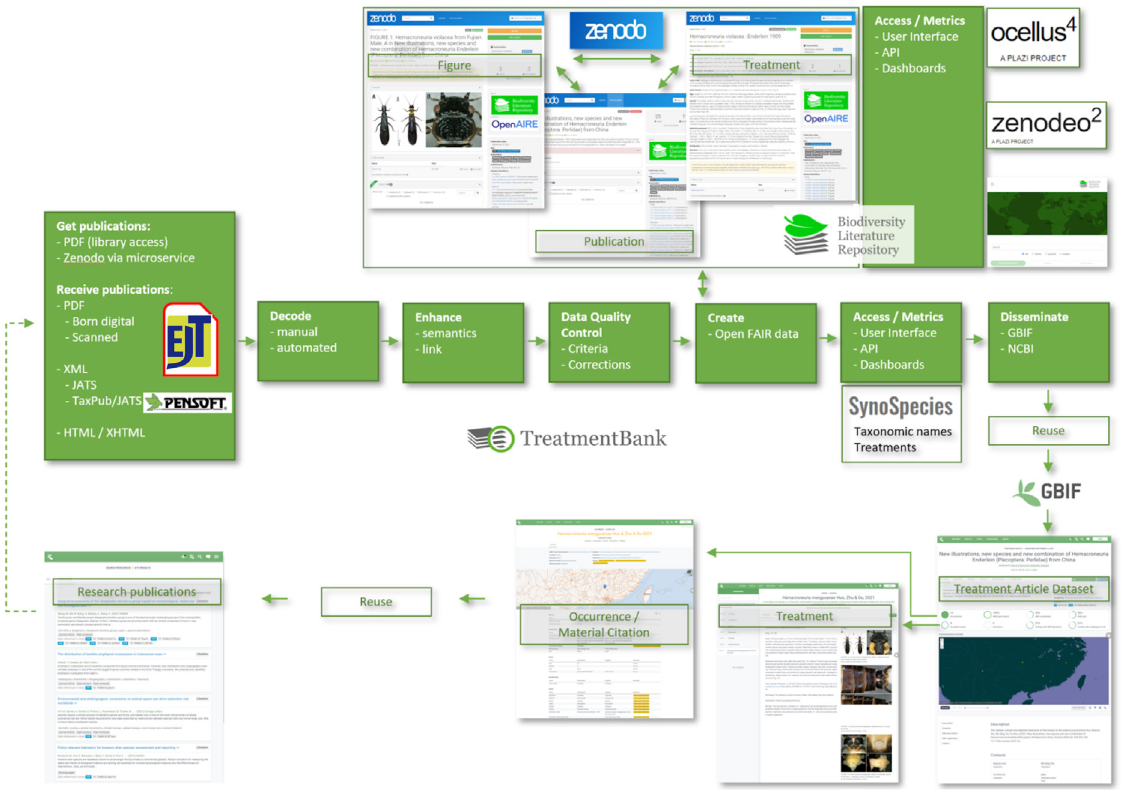
Fig. 1. Publishing as part of the research life cycle. Once liberated, the data imprisoned in a single PDF immediately becomes an integral part of research and is reused and cited. Green figures illustrate the TreatmentBank workflow to liberate, FAIRize and disseminate data, and the Biodiversity Literature Repository, the long-term repository for the data. GBIF is one of the main reusers of the data, providing specific access to the material citations and making them FAIR. Finally, scientists reuse data from within GBIF for their research, for example new revisions, which then become incorporated in the liberation process, thus closing the research life